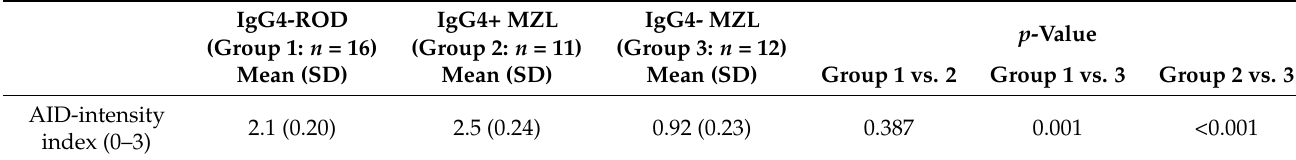
Table 2. Immunohistochemical analysis of activation-induced cytidine deaminase